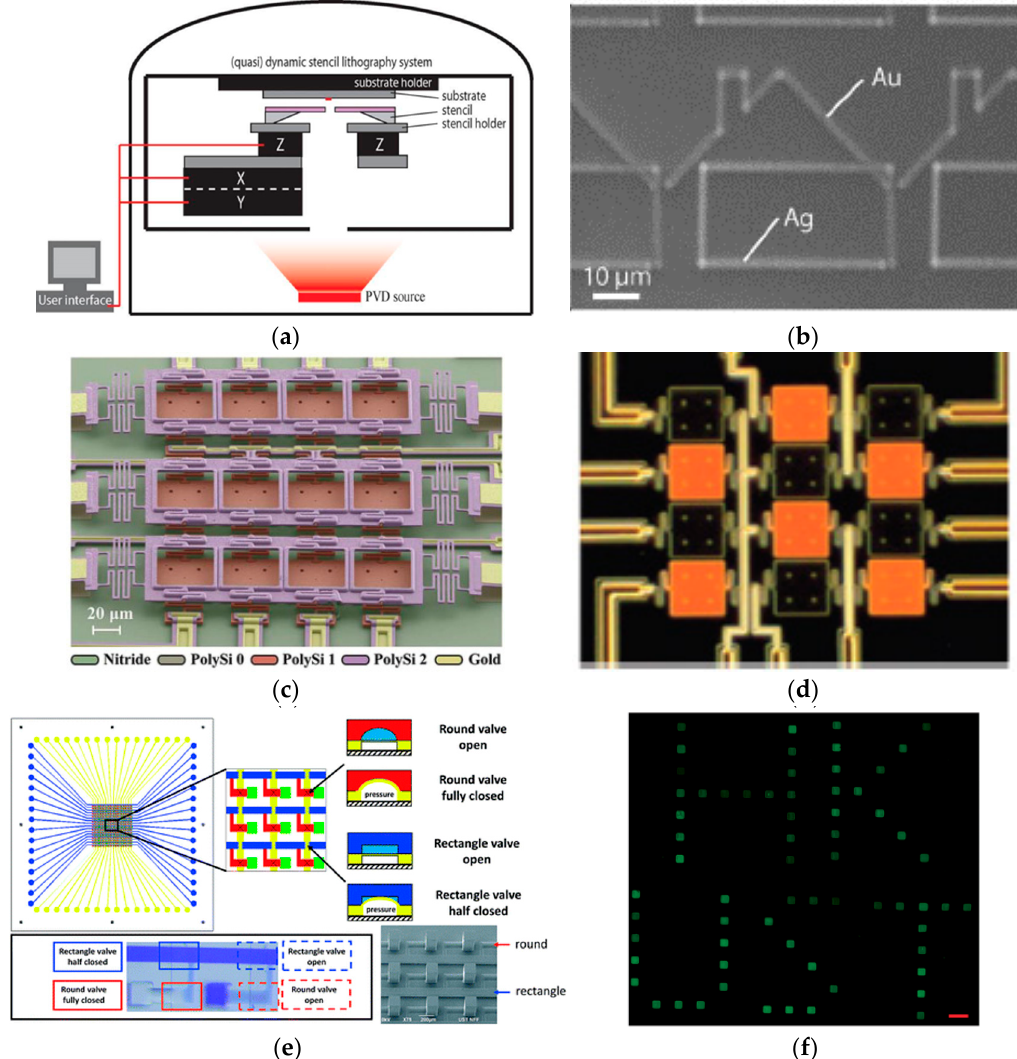
Figure 11. ( a ) Schematic of a dynamic stencil lithography setup. The stencil mask is mounted on a high-precision XY stage, while the substrate holder is fixed at a controlled distance from the stencil by Z actuators. Reprinted with permission from [114]. Copyright [2008], American Vacuum Society; ( b ) parallel fabrication of a multiscale house structure by using dynamic stencil lithography. Reprinted with permission from [114]. Copyright [2008], American Vacuum Society; ( c ) a stencil lithography system with integrated deposition sources. Reproduced from [117] with permission of The Royal Society of Chemistry; ( d ) independent actuation of deposition sources for precise patterning of metal atoms. Reproduced from [117] with permission of The Royal Society of Chemistry; ( e ) a digital microfluidic programmable stencil lithography technique for protein and cell patterning. Reproduced from [121] with permission of The Royal Society of Chemistry; ( f ) protein patterning made by using microfluidic programmable stencil lithography. Reproduced from [121] with permission of The Royal Society of Chemistry.